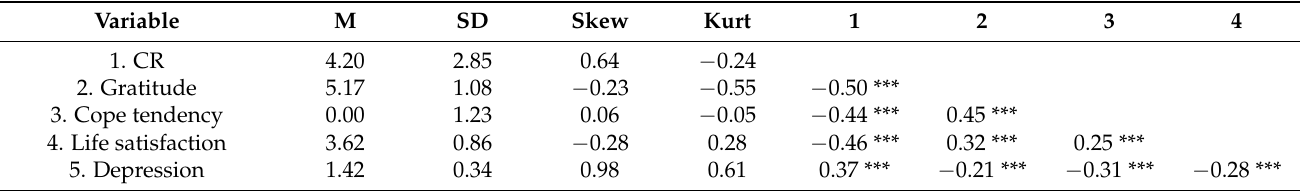
Table 1. Descriptive statistics and correlations for the main variables ( n =